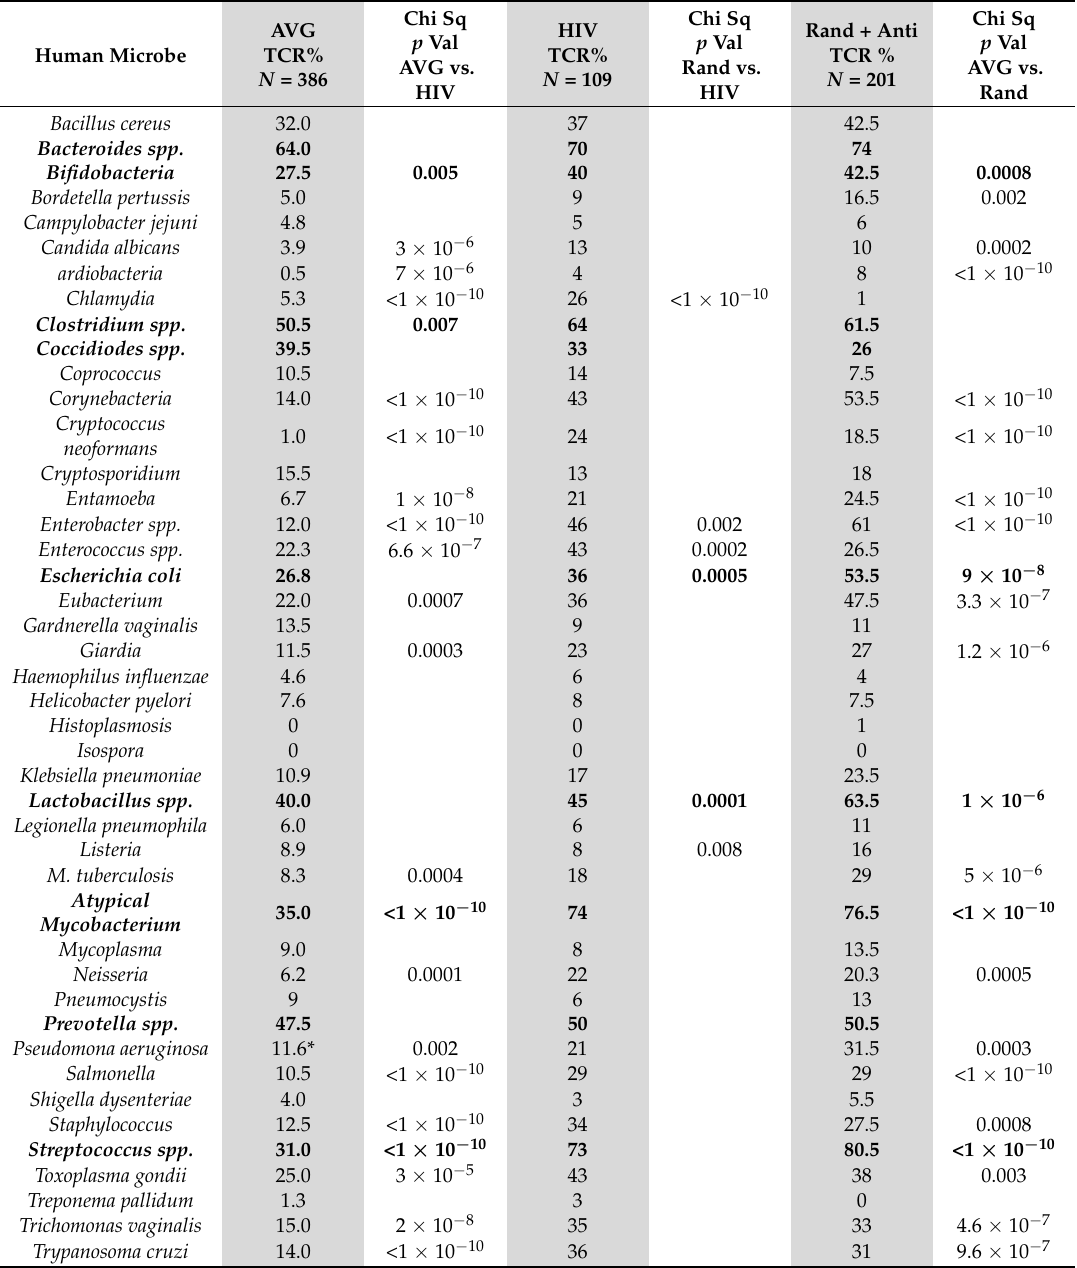
Table 2. HIV mimics TCR far more frequently than any bacterium, fungus or protozoa with the exception of the class of Bacteroides